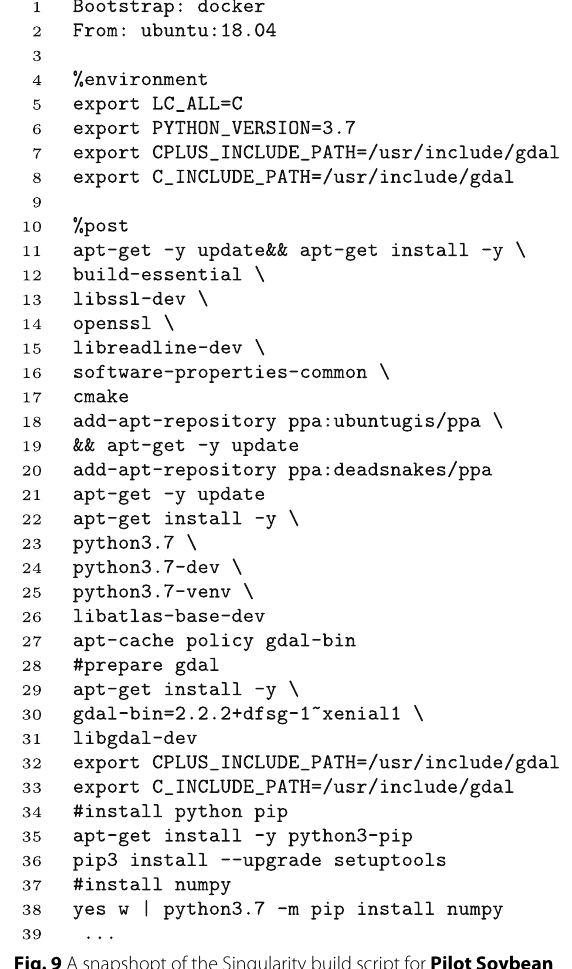
Fig. 9 A snapshopt of the Singularity build script for Pilot Soybean